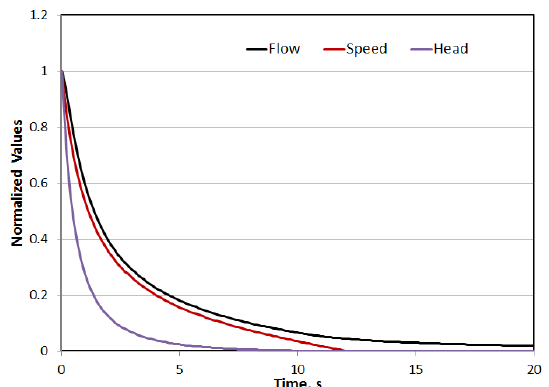
Figure 2. Normalized pump head, speed, and flow in MSRE primary